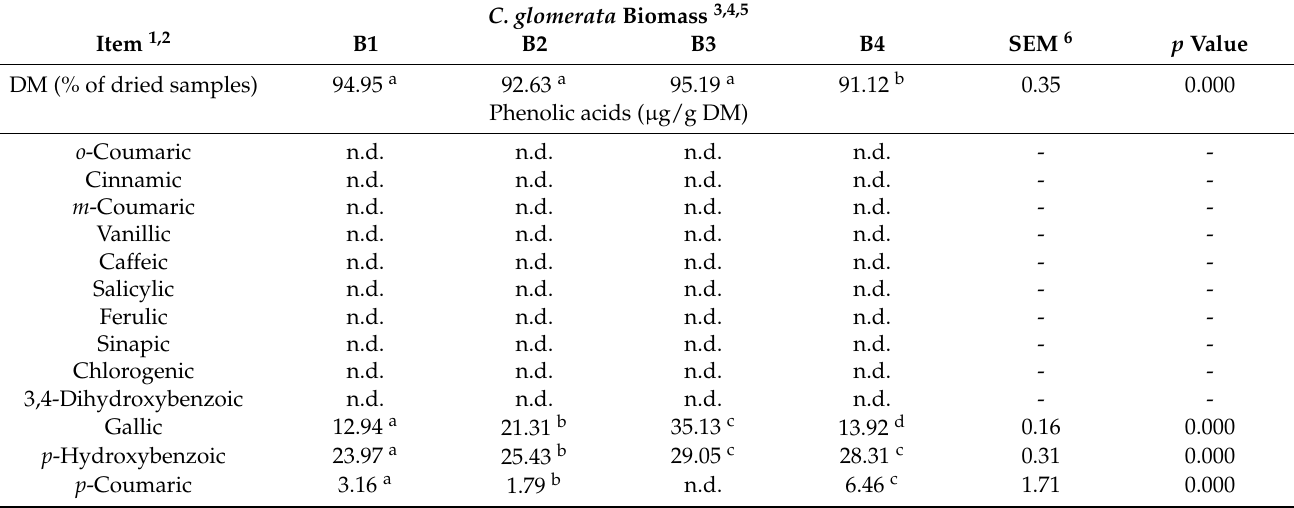
Table 2. Phenolic compounds profile of C. glomerata biomass from various rivers in Lithuania. C. glomerata Biomass